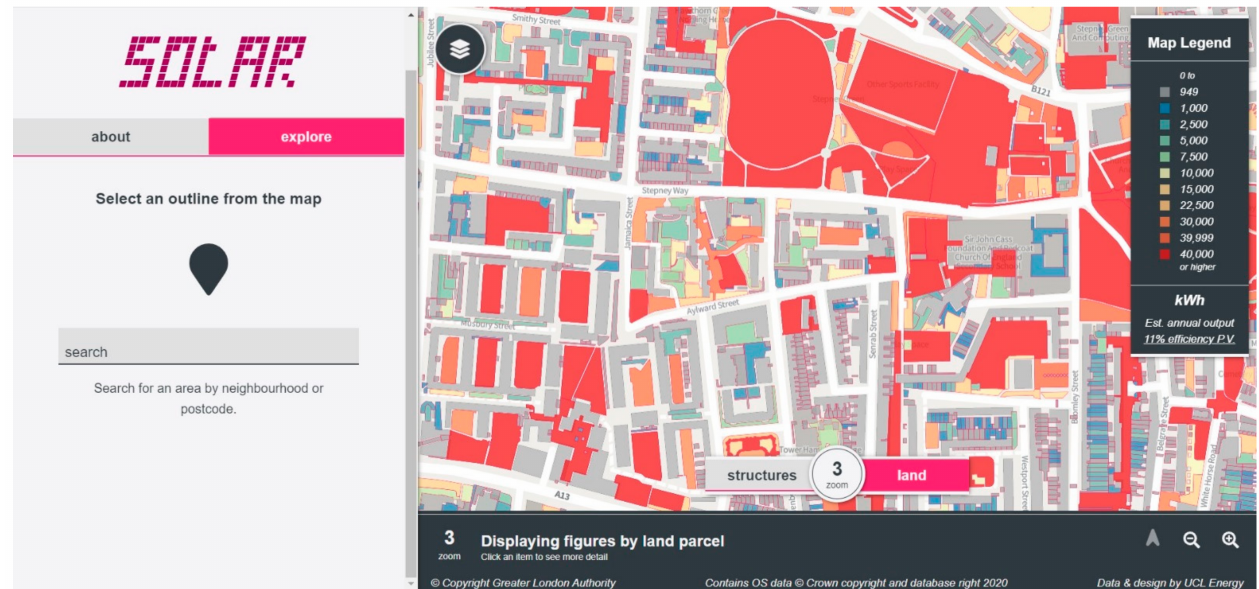
Figure 7. Solar cadastre in London—structures mode: buildings or land can be selected. Source: own study based on [107]. Some of the currently available solar cadastres use 3D visualization (e.g., Vienna, Berlin, Switzerland, etc.), whereas others use only 2D visualization (e.g., Hannover, Hessen, Wroclaw, etc.). Some of them do not consider the structural and static properties of the